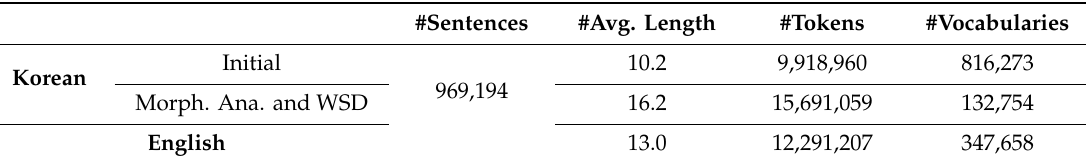
Table 10. The details of the Korean-English parallel corpus in UPC. Morph. Ana. = morphological